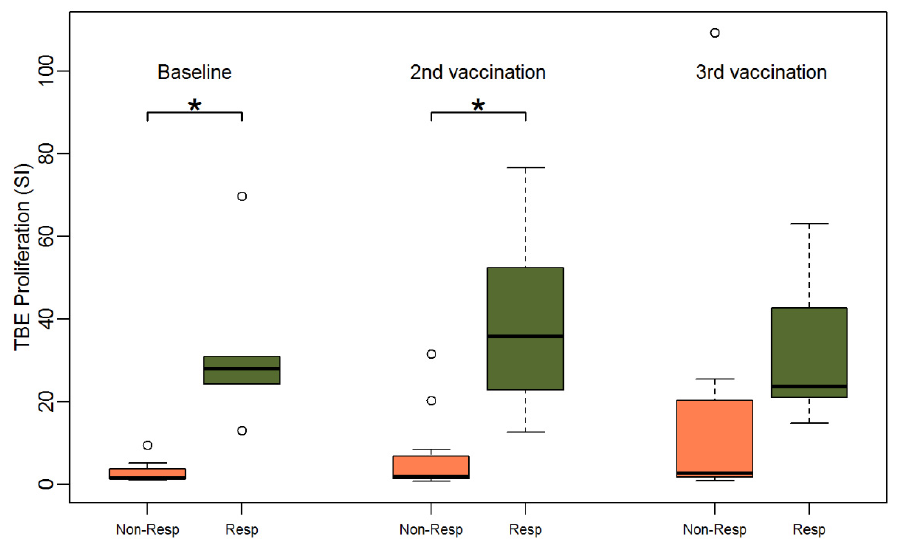
Figure 3. Boxplots showing the median and distribution of lymphocyte proliferation as detected by thymidine incorporation assay (the stimulation indices are given) at three different time points for humoral non-responders (orange) and responders (green) after stimulation with TBE antigen (response was defined as NT ≥ 10 and at least two-fold increase in titer after two vaccinations). Asterisk marks significant p -value (baseline: p < 0.001; 2nd vaccination: p = 0.0019).